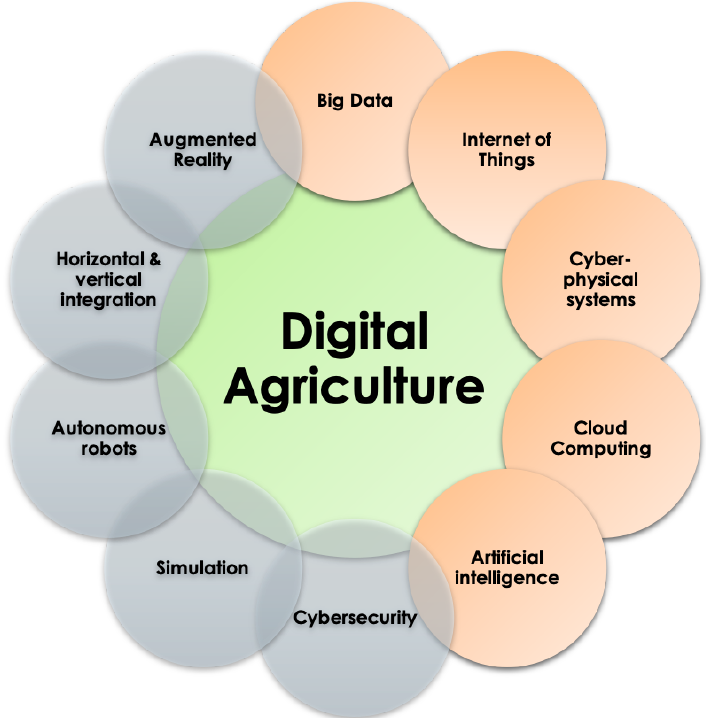
Figure 1. Reuse of the 10 technologies of Industry